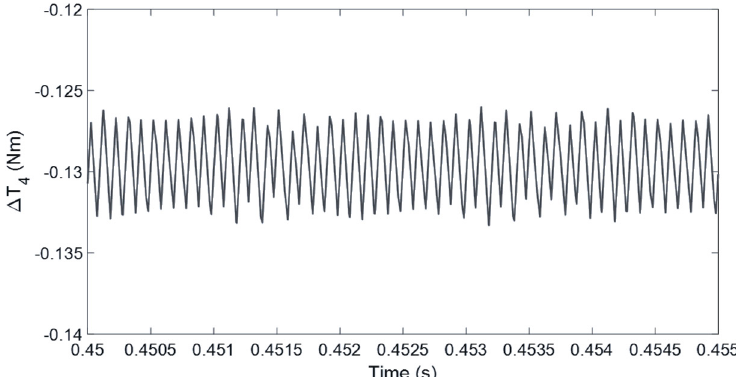
Figure 20. The fourth torque variation term for proposed rSVM-DTC.